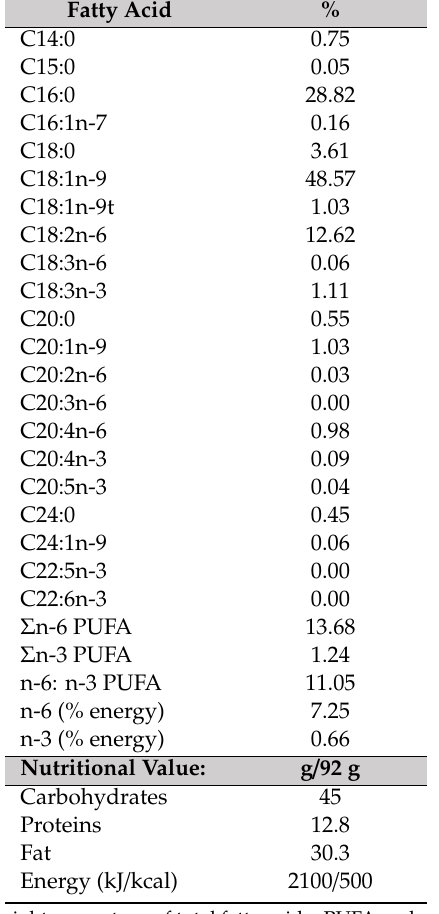
Table 1. Fatty acid (FA) composition (% wt / wt) and nutrient content / portion (92 g) of Plumpy’nut ® , the ready-to-use therapeutic food (RUTF) used in treatment of severe acute malnutrition (SAM) in this study. Data from [16] and